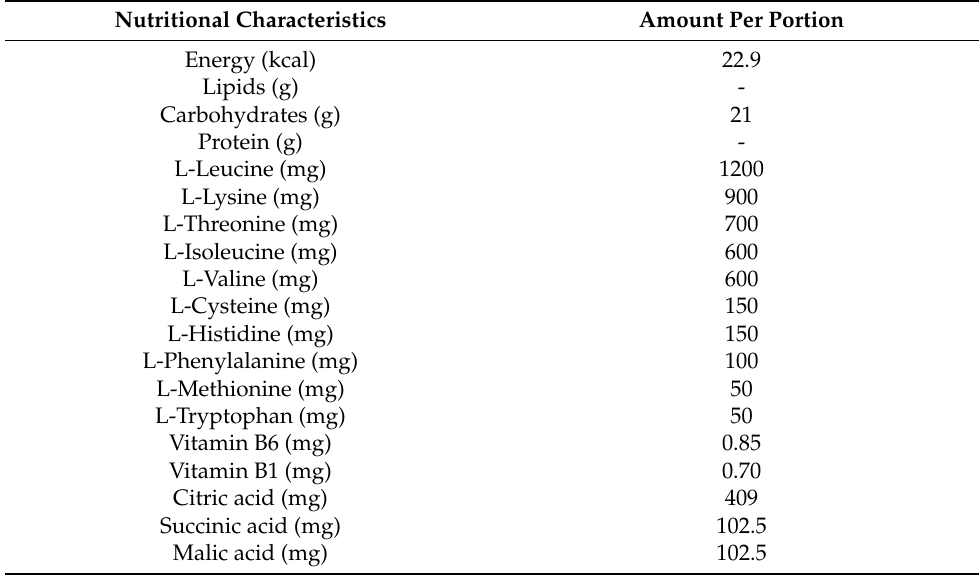
Table 1. Characteristics of oral nutritional supplement Amino-Ther Pro (Professional